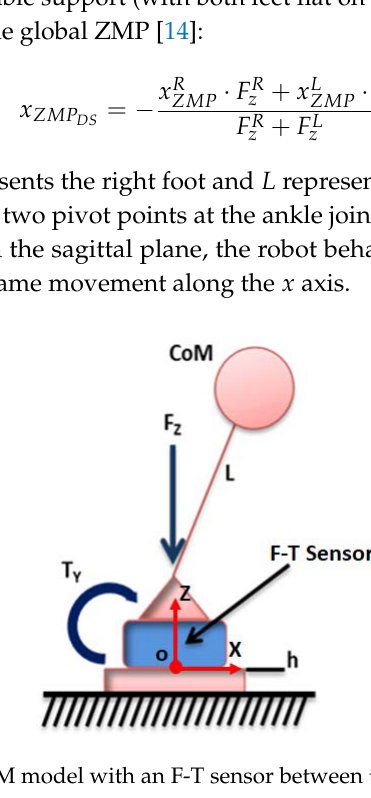
Figure 7. The LIPM model with an F-T sensor between the sole and ankle